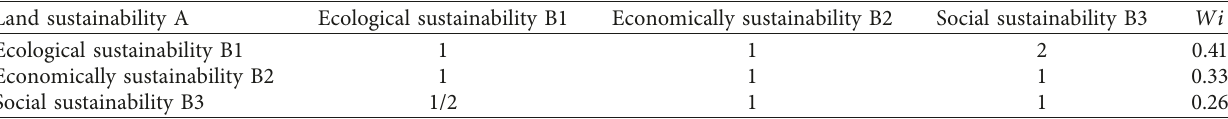
Table 7: Weights of indicators of judgment matrix A-B and layer B.